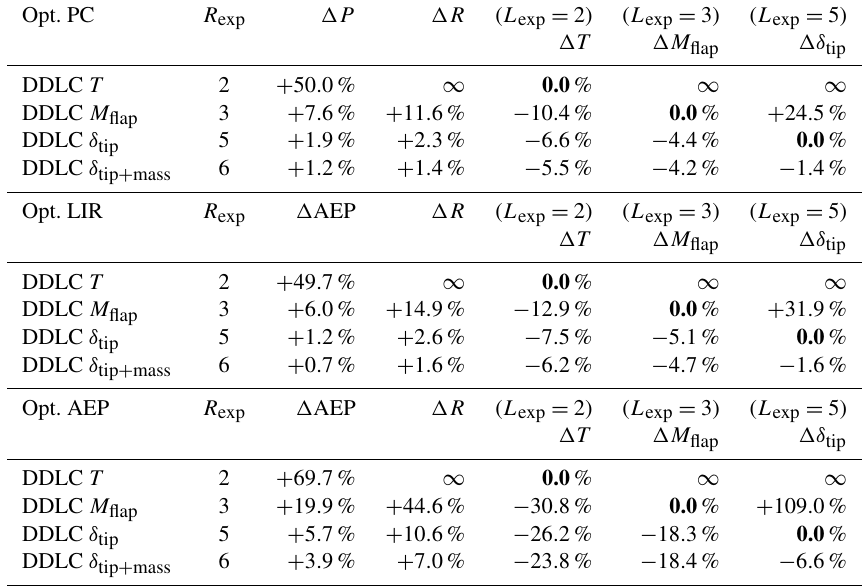
Table 1. Overview of the optimization results from optimizing power capture (Opt. PC), low-induction rotor (Opt. LIR) and annual energy production (Opt.